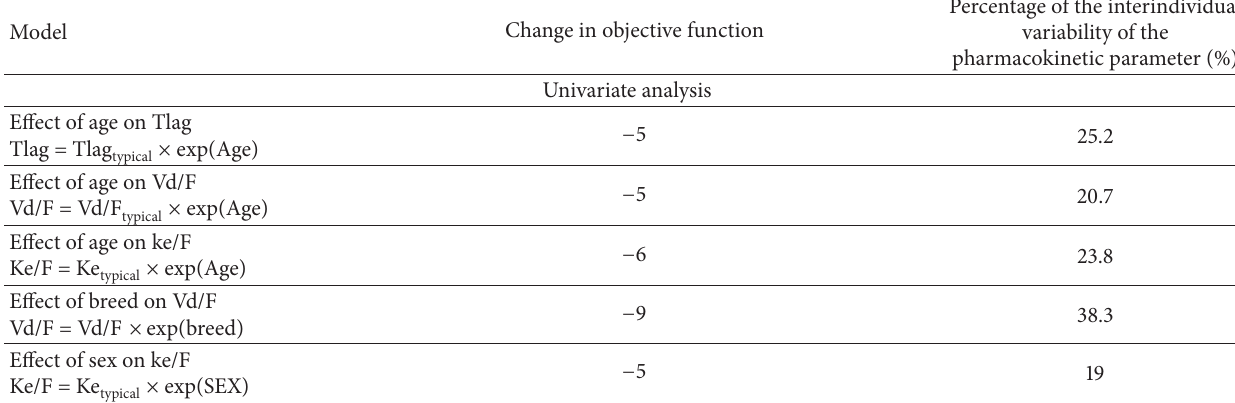
Table 2: Pharmacokinetic model building.